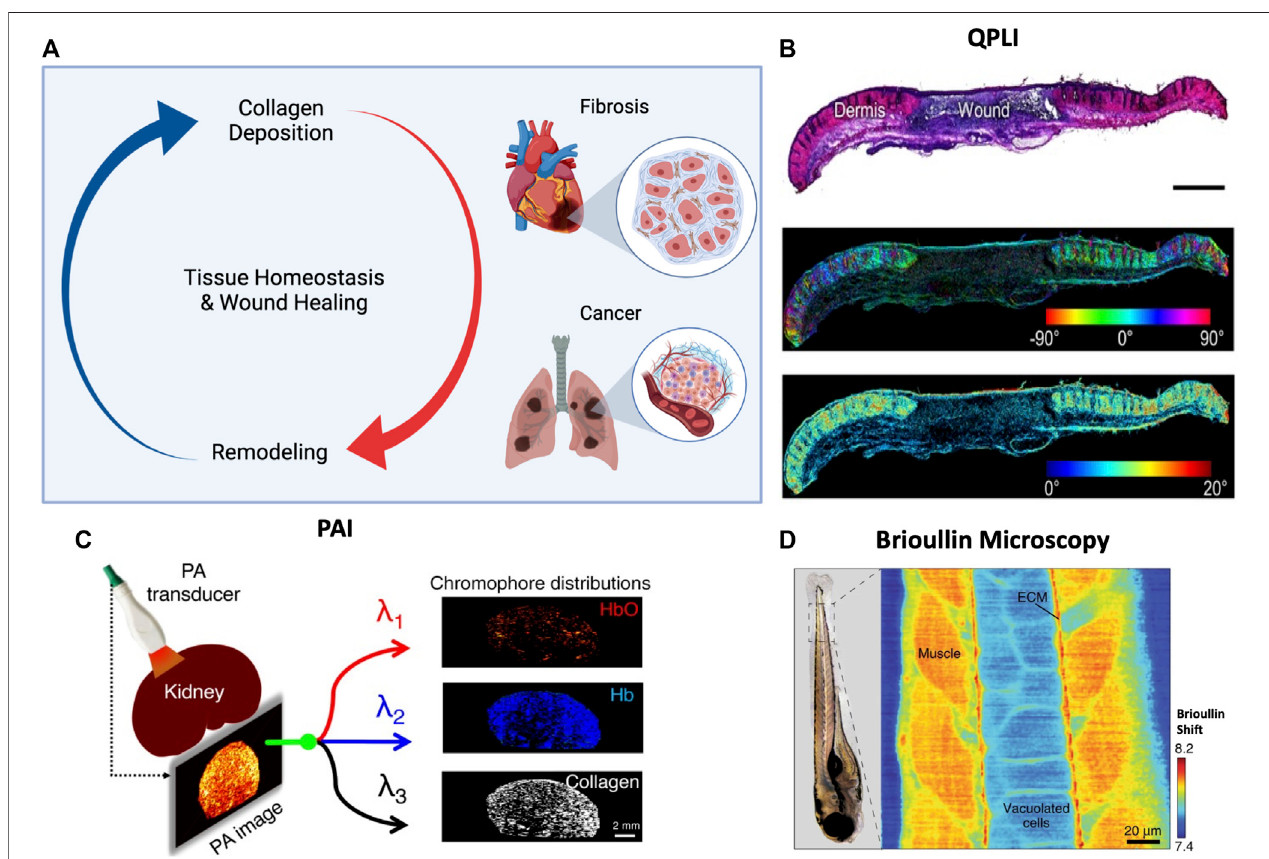
FIGURE3|(A) Propertissuehomeostasisandwoundhealingisgovernedbyanintricatebalanceofcollagendepositionandremodeling.Whenthiscyclebecomes dysfunctional, pathologies like fi brosis and cancer canbecome prevalent. Created with BioRender.com. (B) QPLI hasbeen used tomonitor wound healing indermisvia tracking changes incollagen fi ber orientationand birefringence.Reproducedwith permission from Woessner et al.(2019). (C) Spectralunmixing inPAIisused toisolate quantify collagen content and hemoglobin in kidney. Reproduced with permission from Hysi et al. (2020). (D) Brillouin frequency shift maps in zebra fi sh tail discern local difference in mechanics between muscle and ECM. Reproduced with permission from Prevedel et al. (2019).